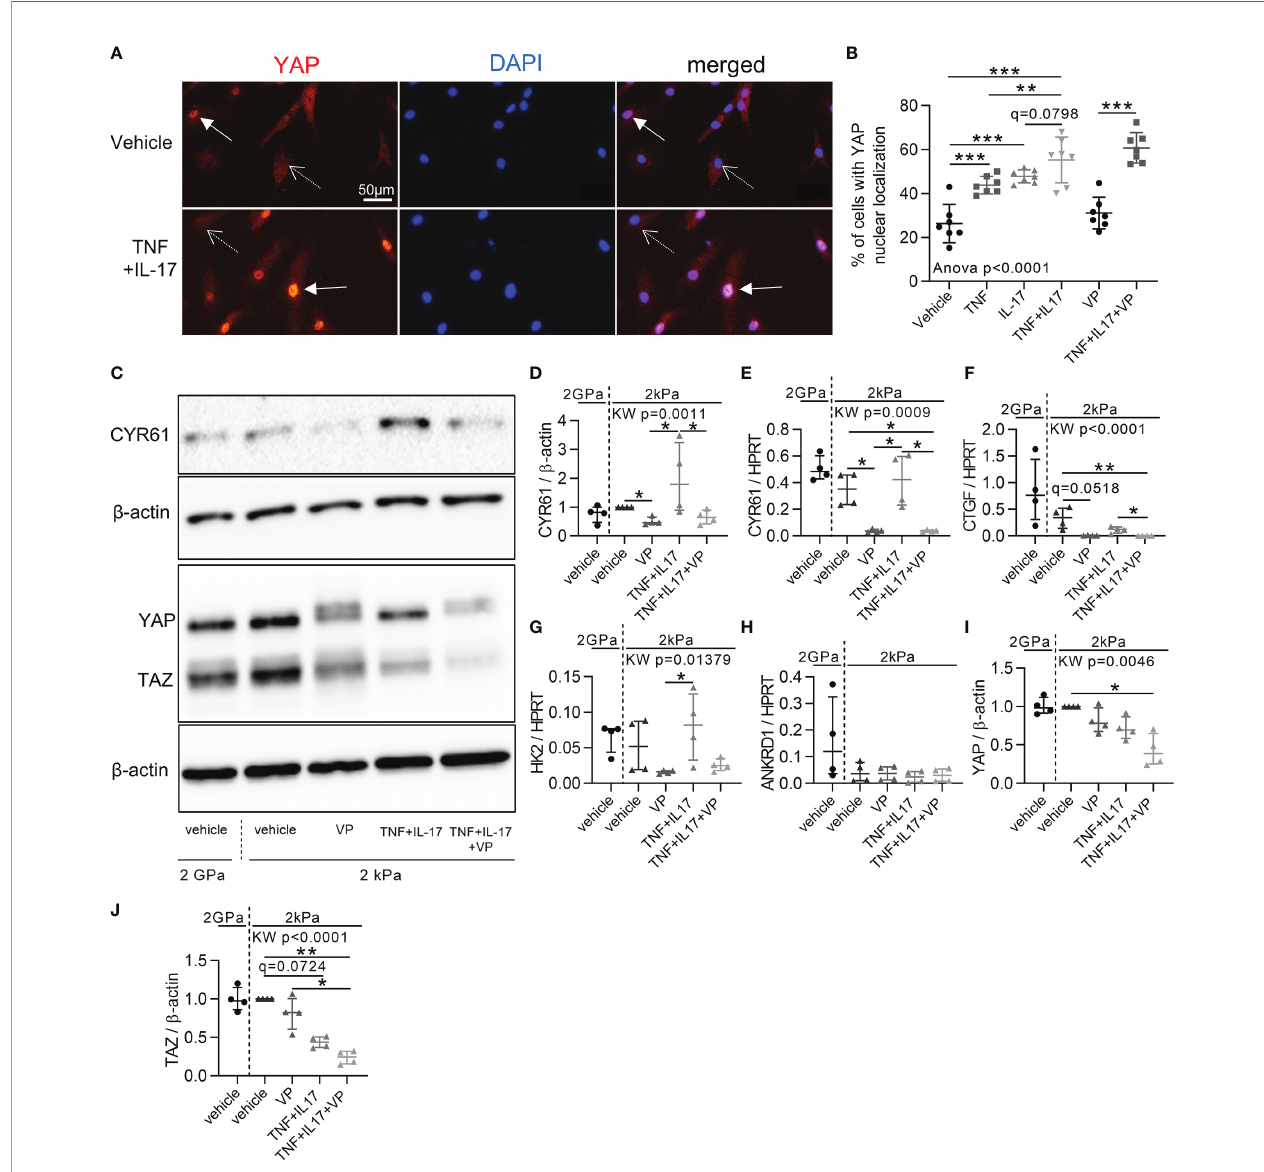
FIGURE 2 | Increased YAP/TAZ transcriptional activity in RA FLS by in fl ammation. RA FLS (n=4 patients) were cultured on soft (2 kPa) or classic stiff (2 GPa) substrates as indicated with VP, TNF, IL-17 alone or in combination for 48 hours. (A) Epi fl uorescence representative images of YAP (immuno fl uorescence, orange), DAPI (nucleus, blue), and merged images of RA FLS in 2kPa conditions. Arrows: positive YAP nuclear localization; dotted arrows: negative YAP nuclear localization. (B) Corresponding quanti fi cation for FLS from one RA patient (n=7). Experiments were repeated for FLS for three others RA patients showing the same pattern. (C) Representative western blot results of total YAP-TAZ, CYR61, and b -actin with their quanti fi cations normalized to the 2 kPa group for each patient and to b -actin (D, I, J) . (E – H) RT-qPCR quanti fi cations of CYR61, CTGF, HK2 and Ankrd1 expression normalized to HPRT expression. Data were presented as individual values with mean ± SD (B) or median and interquartile range (D – J) . ANOVA or Kruskal Wallis (KW) test with FDR corrected (q-value) for multiple comparisons post hoc tests between soft conditions (2kPa): *q < 0.05; **q < 0.01; ***q < 0.001. Vertepor fi n (VP), 10 µM; tumor necrosis factor (TNF), 10 ng/ml; Interleukin-17 (IL-17), 50 ng/ml; TAZ, transcriptional co-activator with PDZ-binding